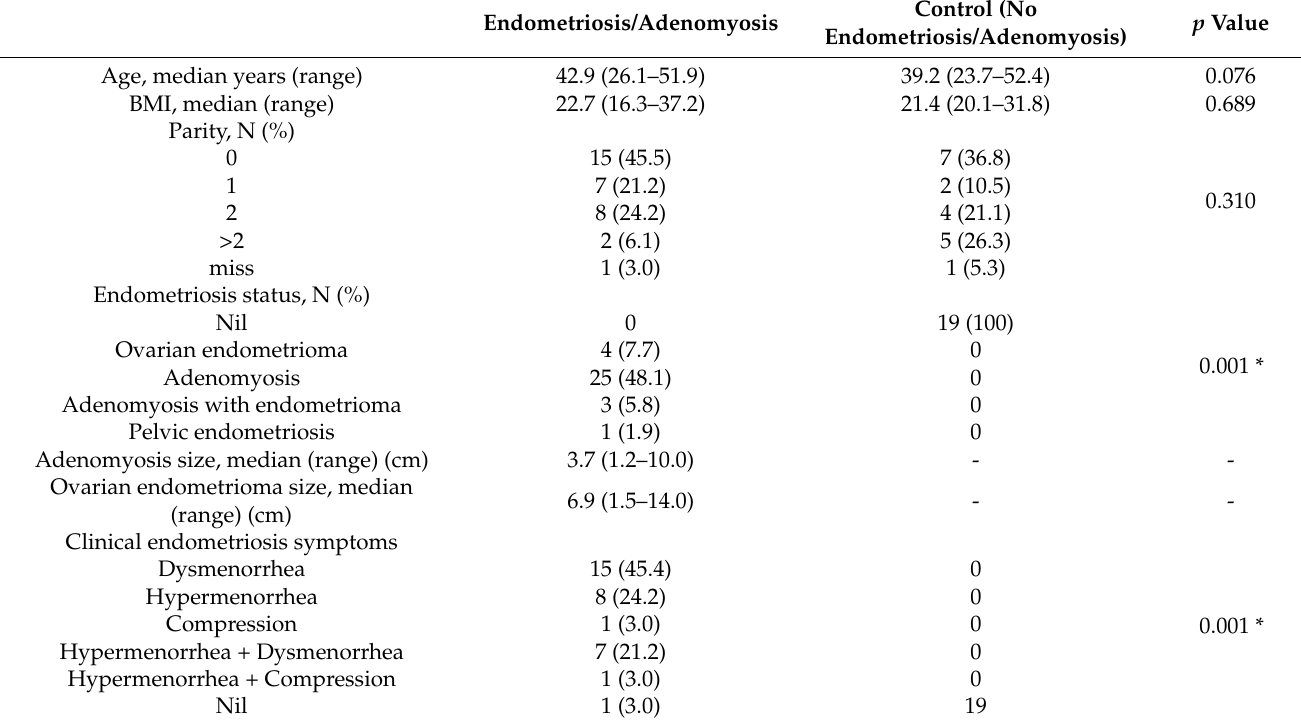
Table 1. Patient